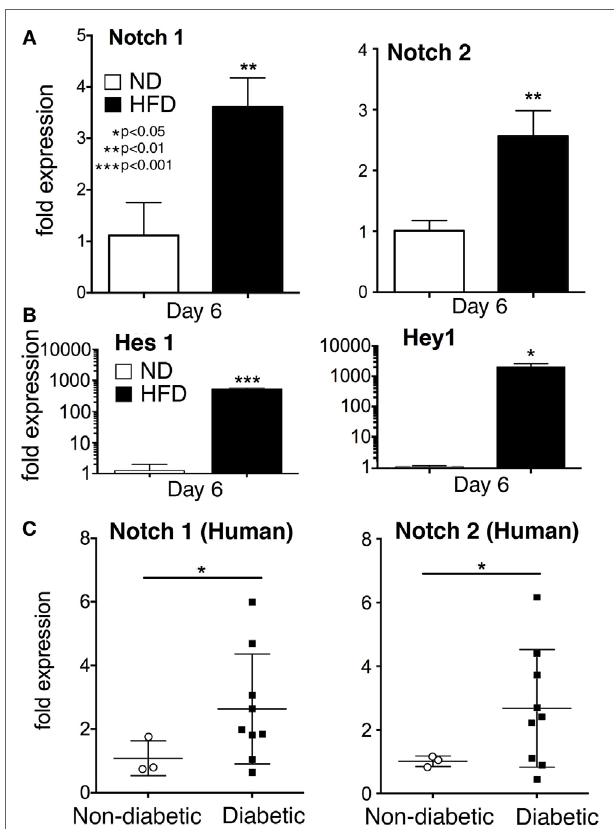
FigUre 5 | notch signaling is increased in monocytes from type 2 diabetic (T2D) patients and wound macrophages from a murine model of obesity/type 2 diabetes (T2D) . Diet-inducted obesity, a physiologic model of “prediabetes,” was used to examine the effect of obesity and insulin resistance on Notch signaling in wound macrophages. C57Bl/6 mice were fed either normal diet (ND) (12% saturated fat) or a high-fat diet (HFD) (60% saturated fat) for 12–14 weeks. Mice on a HFD (diet-induced obese) were wounded on the back using a 4 mm